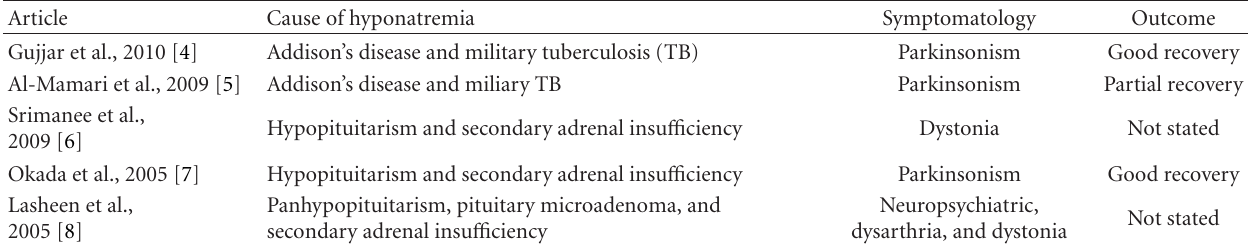
Table 1: Cases in the literature with parkinsonism and isolated EPM with adrenal insu ffi ciency. Article Cause of hyponatremia Symptomatology Outcome Gujjar et al., 2010 [4] Addison’s disease and military tuberculosis (TB) Parkinsonism Good recovery Al-Mamari et al., 2009 [5] Addison’s disease and miliary TB Parkinsonism Partial recovery Hypopituitarism and secondary adrenal insu ffi ciency Dystonia Not stated Hypopituitarism and secondary adrenal insu ffi ciency Parkinsonism Good recovery Panhypopituitarism, pituitary microadenoma, and Neuropsychiatric, Not 2005 [8] secondary adrenal insu ffi ciency dysarthria, and dystonia